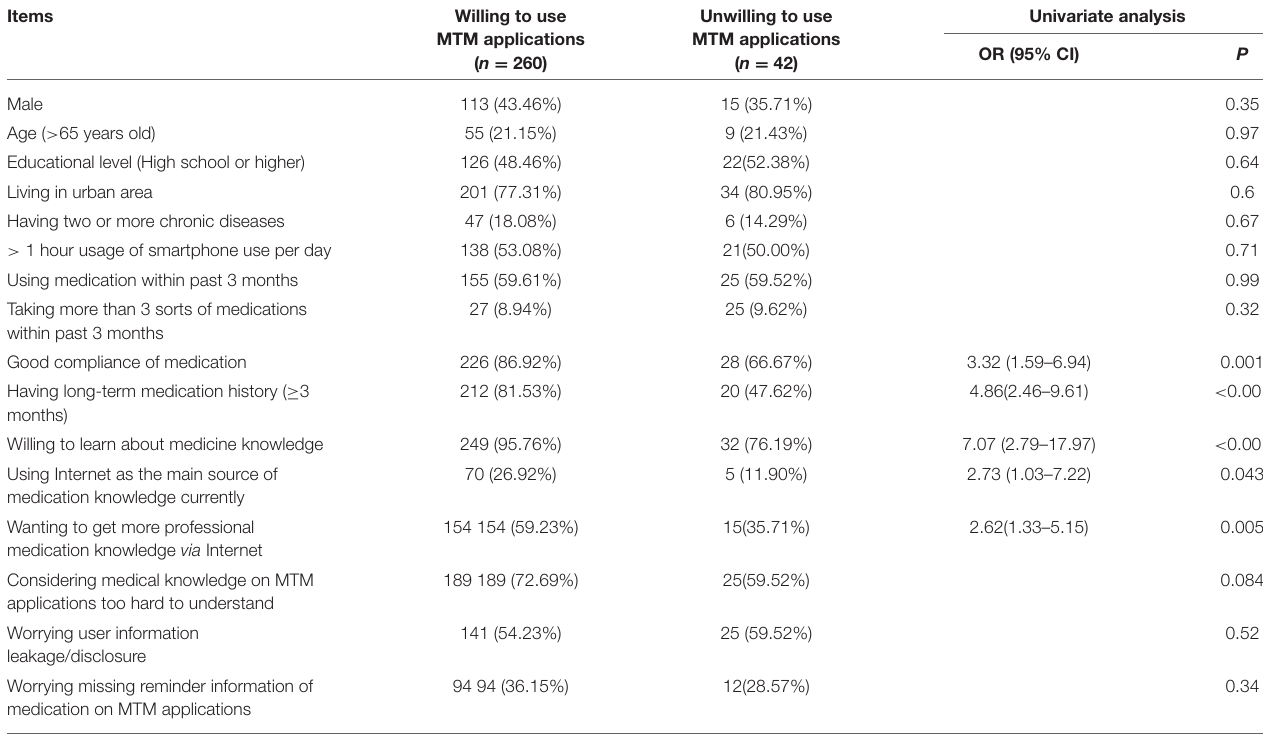
TABLE 3 | Univariate analysis of influencing factors associated with the willingness to install and use MTM applications.